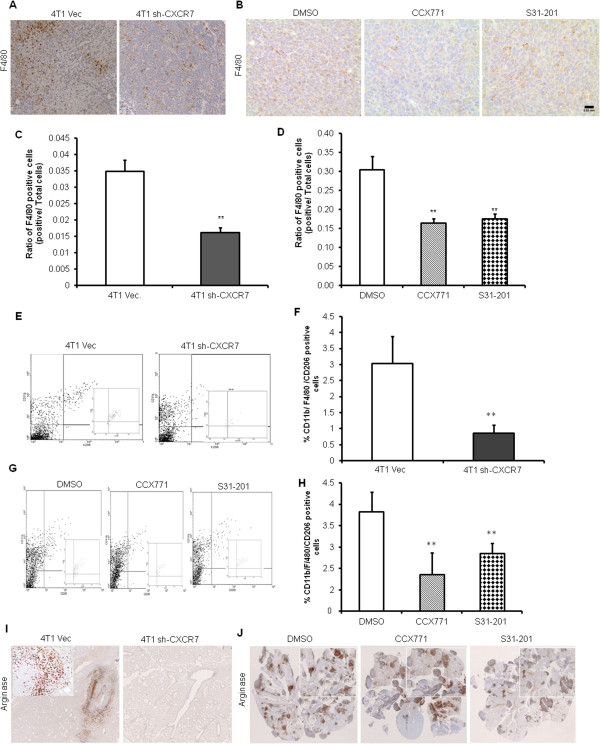
CXCR7 enhances recruitment of M2 macrophages into tumor stroma. Tumors from mice used in experiment presented in Figure 2 were subjected to IHC (20×) staining for macrophage marker, F4/80. (A) Representative image of 4T1 Vec and 4T1 sh-CXCR7 (B) 4T1.2 tumors treated with either DMSO or CXCR7 inhibitor (CCX771) or STAT3 inhibitor (S31-201). The F4/80+-stained cells were counted in four different fields by using bright-field microscope in each experimental group, and the average was calculated. Bars represent the mean ± SD of number of F4/80 macrophages (C) 4T1 Vec, 4T1 sh-CXCR7 and (D) 4T1.2 tumors treated with either DMSO or CXCR7 inhibitor (CCX771) or STAT3 inhibitor (S31-201). CD11b+F4/80+CD206+ cells in tumors were quantified by flow cytometry (E, F) 4T1 and 4T1 sh-CXCR7 (G, H) 4T1.2 tumors treated with either DMSO or CXCR7 inhibitor (CCX771) or STAT3 inhibitor (S31-201). Lungs were removed and stained for Arginase-1 (5X) (I) 4T1 Vec or 4T1 sh-CXCR7 (insets: 40× magnification) and (J) 4T1.2 tumors treated with either DMSO or CXCR7 inhibitor (CCX771) or STAT3 inhibitor (S31-201) (2.5×; insets, 10× magnification). Data represent the mean ± SD per experimental group. Scale bars, 0.03 mm. *P < 0.05, **P < 0.01 versus vehicle or vector control.